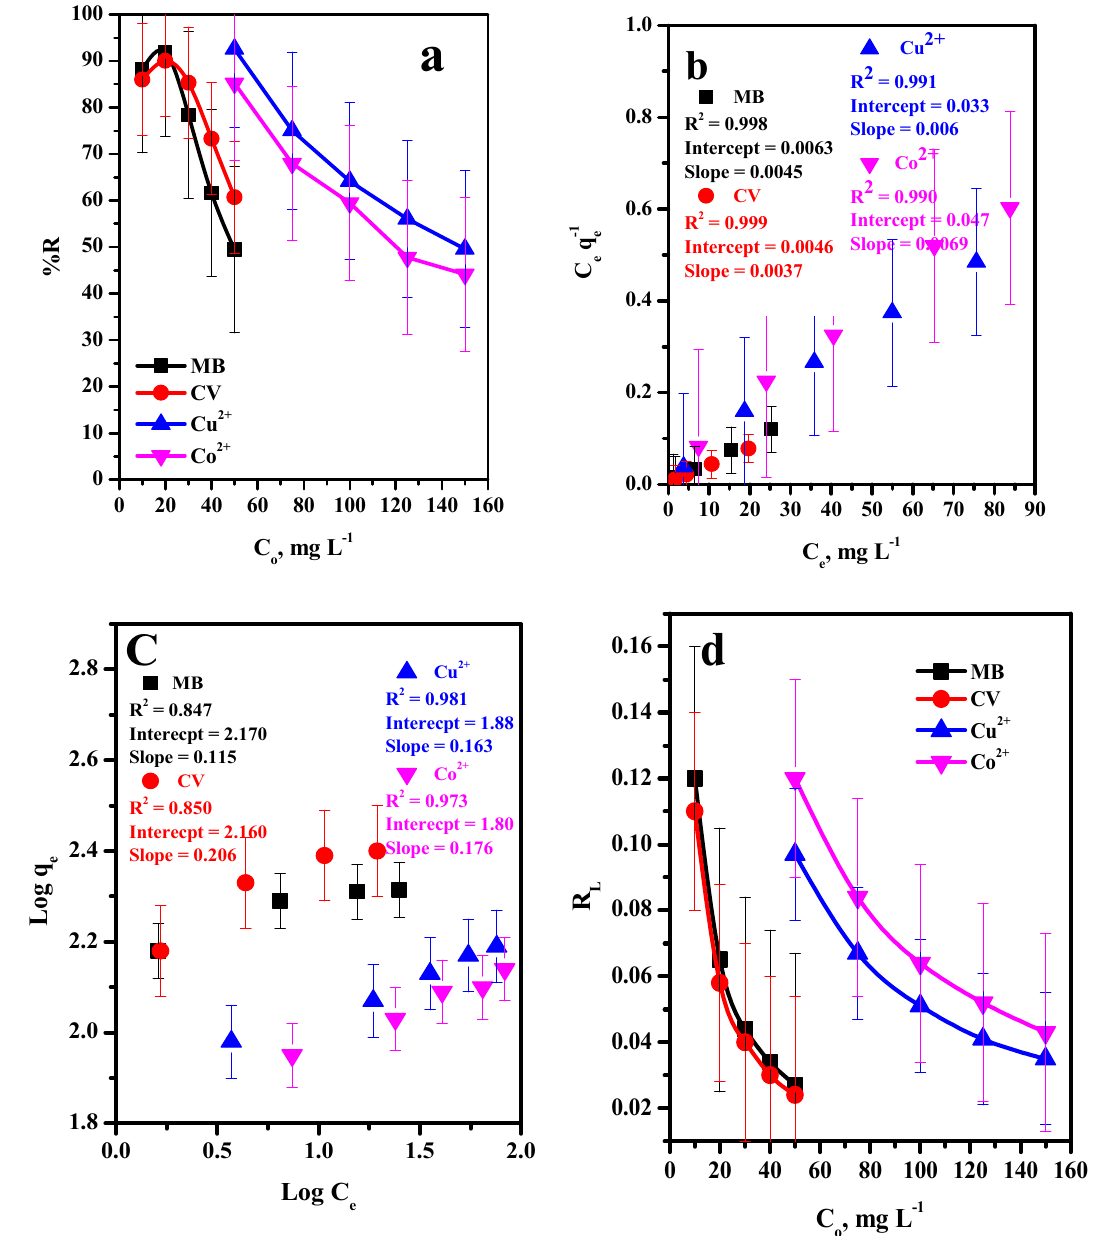
Figure 6. Effect of ( a ) dye concentration on removal percent, ( b ) Langmuir isotherm plot, ( c ) Freundlich isotherm plot ( d ) R L of MB-dye (t = 5 min, Dose = 6 mg, v = 50 ml, pH = 7, T = 30 °C) and CV-dye (t = 7 min, Dose = 6 mg, v = 50 ml, pH = 7, T = 30 °C) Cu 2+ (t = 1 min, Dose = 2.4 mg, v = 5 ml, pH = 6, T = 25 °C) and Co 2+ (t = 1 min, Dose = 2.4 mg, v = 5 ml, pH = 8, T = 25 °C) form pure